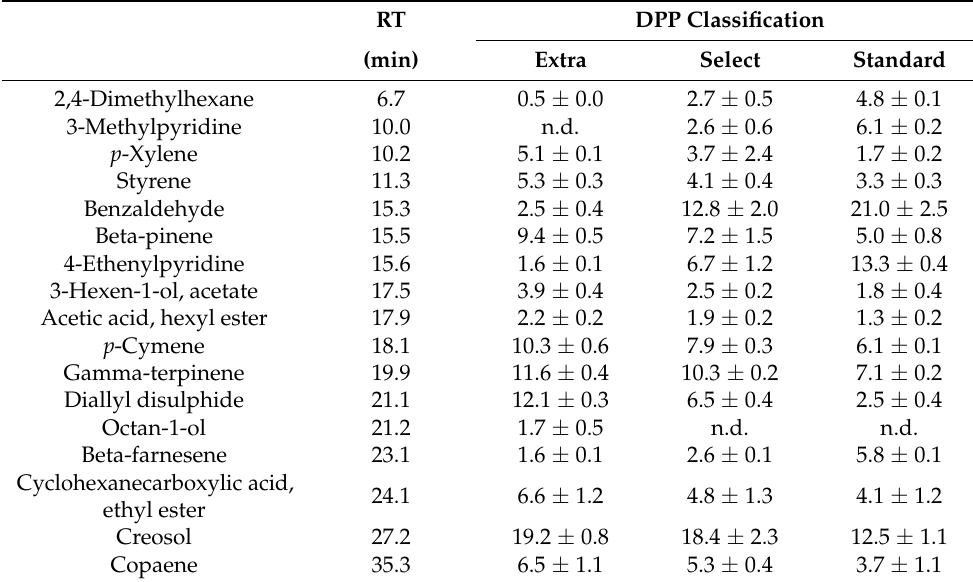
Table 5. Relative contents of volatile compounds (mean % ( n = 3)) obtained from Californian-style black olives stuffed with hydrocolloids submitted to different sterilisation